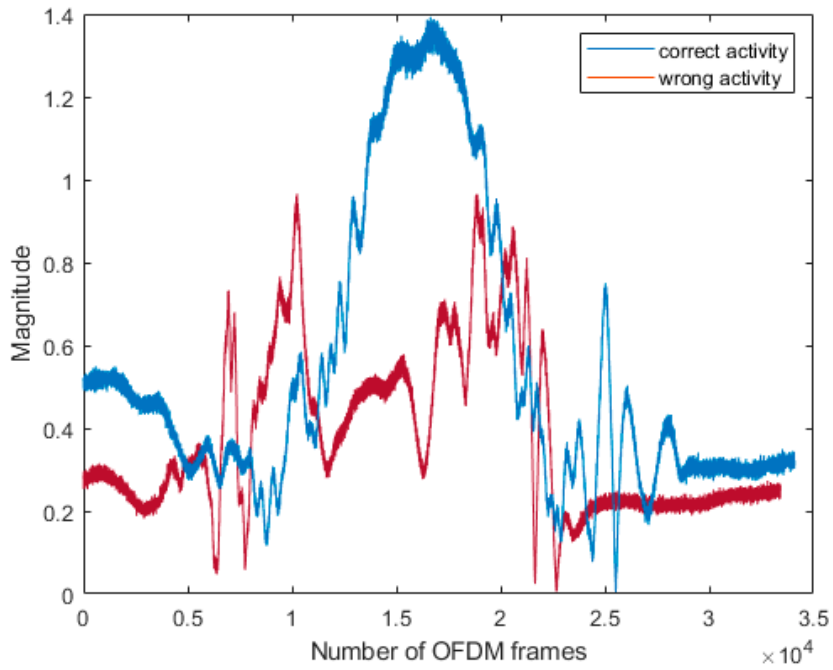
Figure 8. Result of wrong activity using 64-subcarriers.